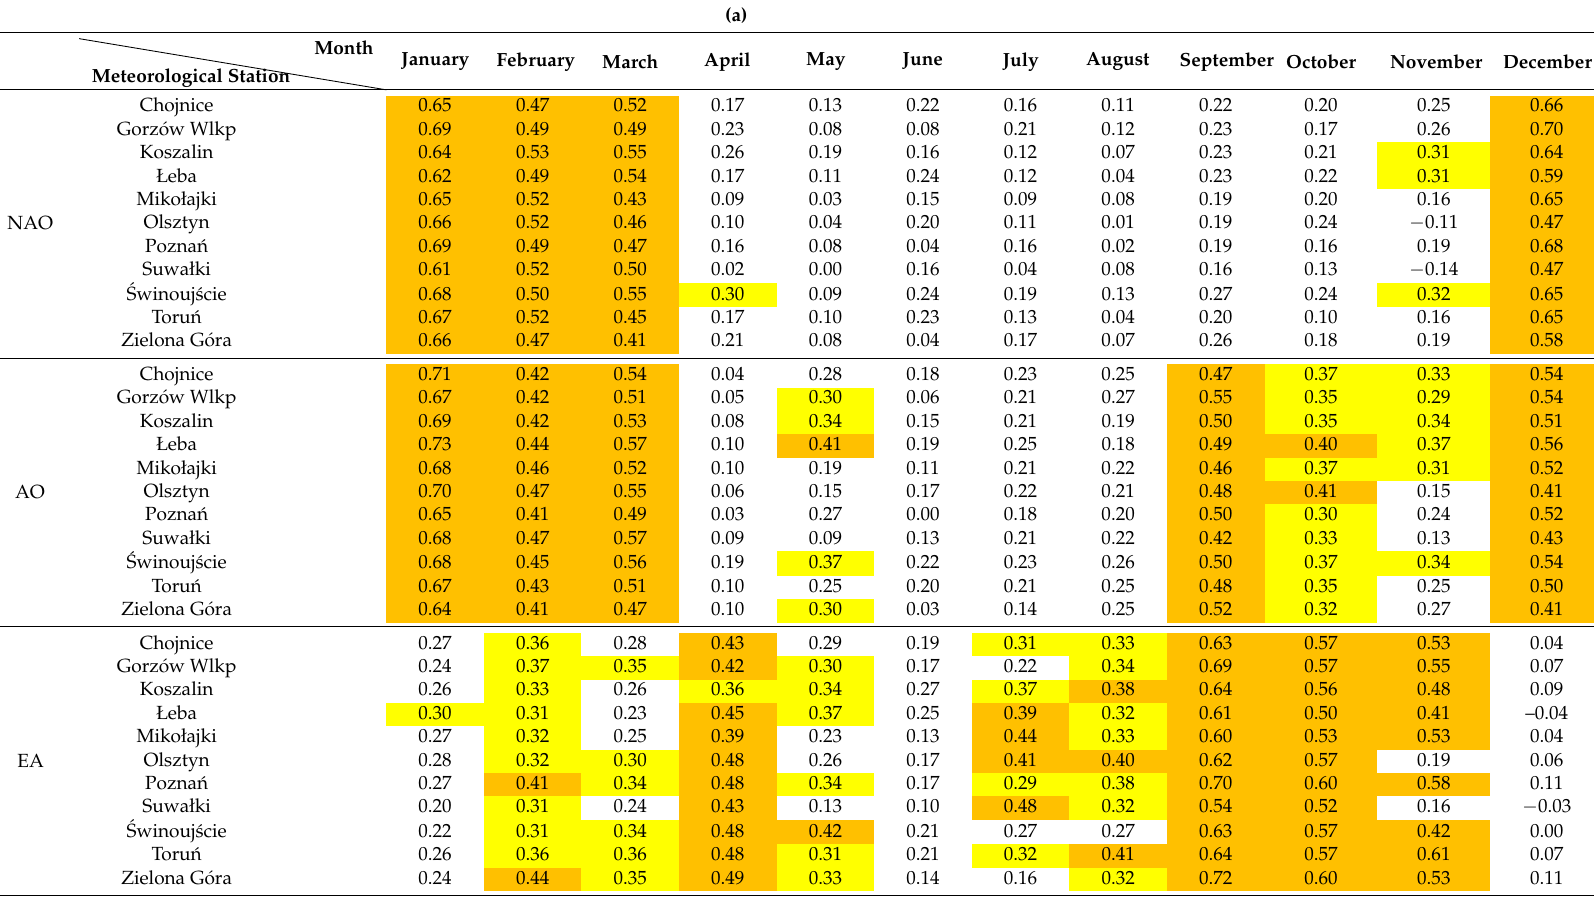
Table 2. Spearman’s coefficient of correlation between indices of macroscale atmospheric circulations types and air ( a ) and lake water temperature ( b ) in Poland, orange color—positive correlation, p < 0.01; yellow color—positive correlation, p < 0.05; dark-blue—negative correlation, p < 0.01; light blue—negative correlation, p <